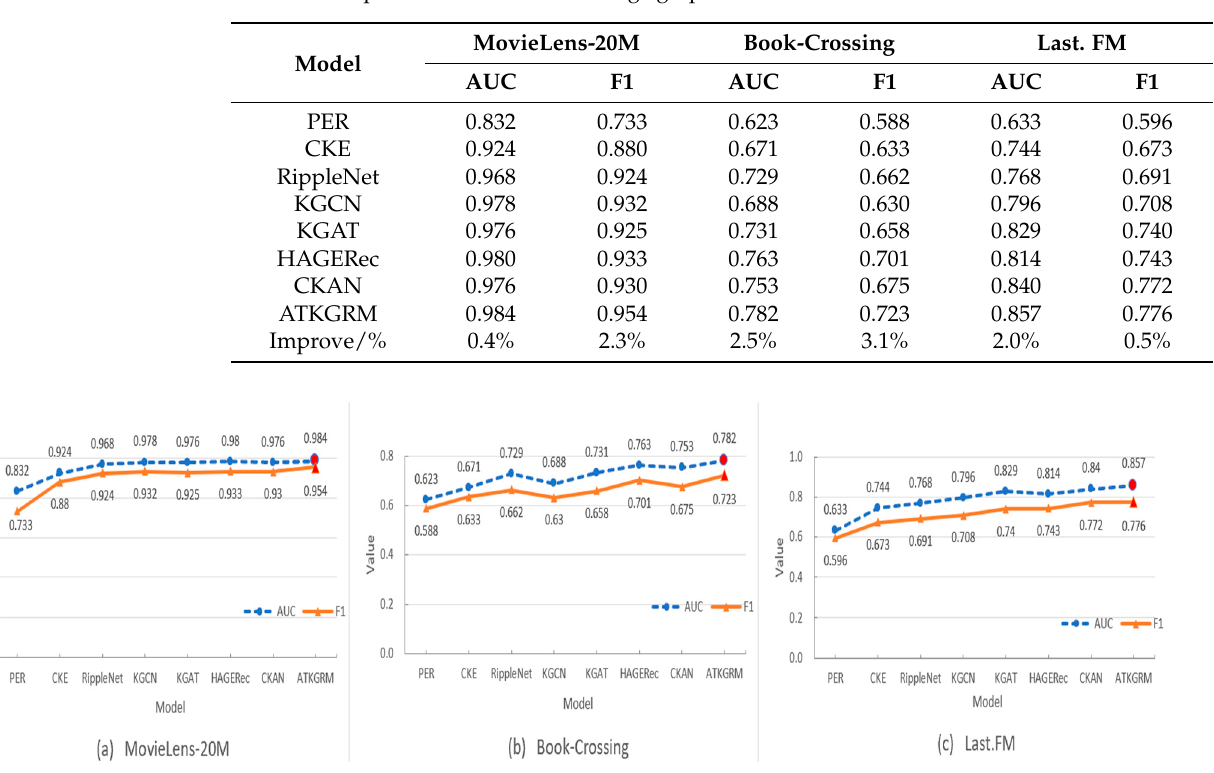
Table 4. Comparison results of knowledge graph recommendation models.